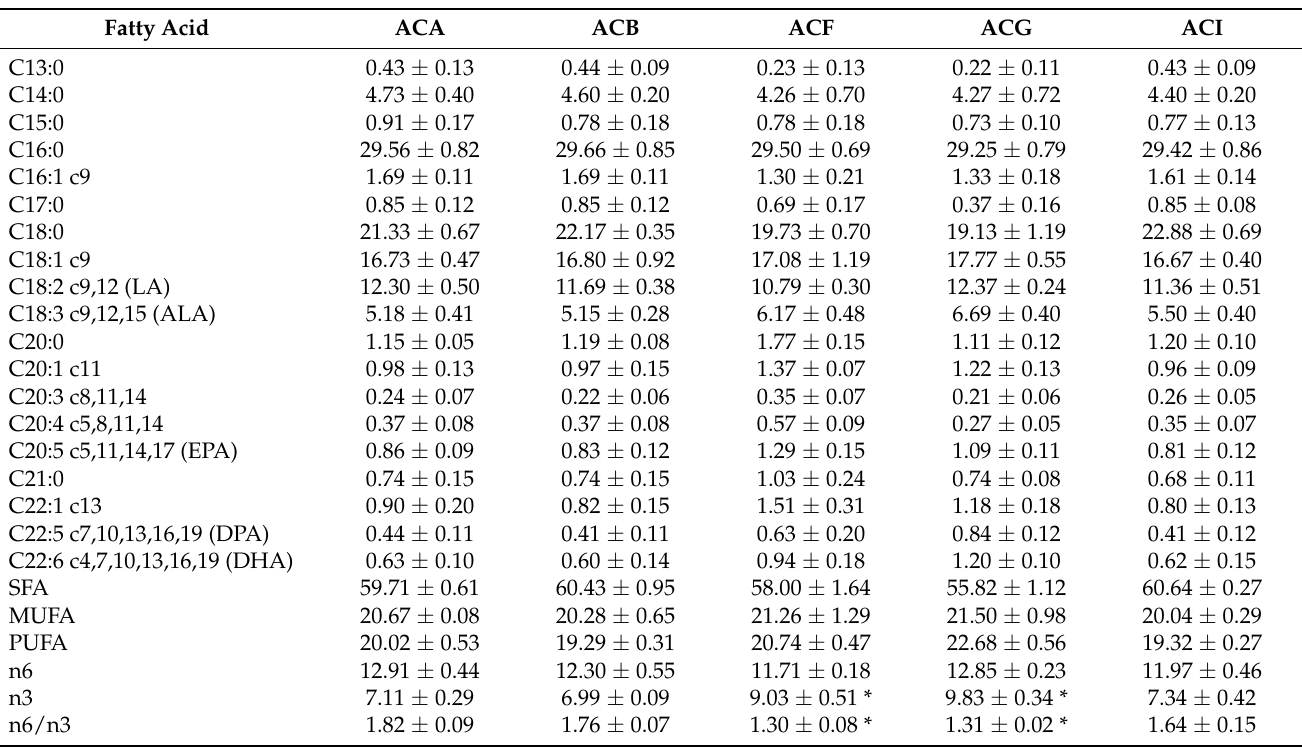
Table 2. The fatty acid profile obtained of the PL of the apple ciders ACA, ACB, ACF, ACG, and ACI, expressed as the percentage of each fatty acid in the total fatty acids for each sample (mean ± SD, n = 3).